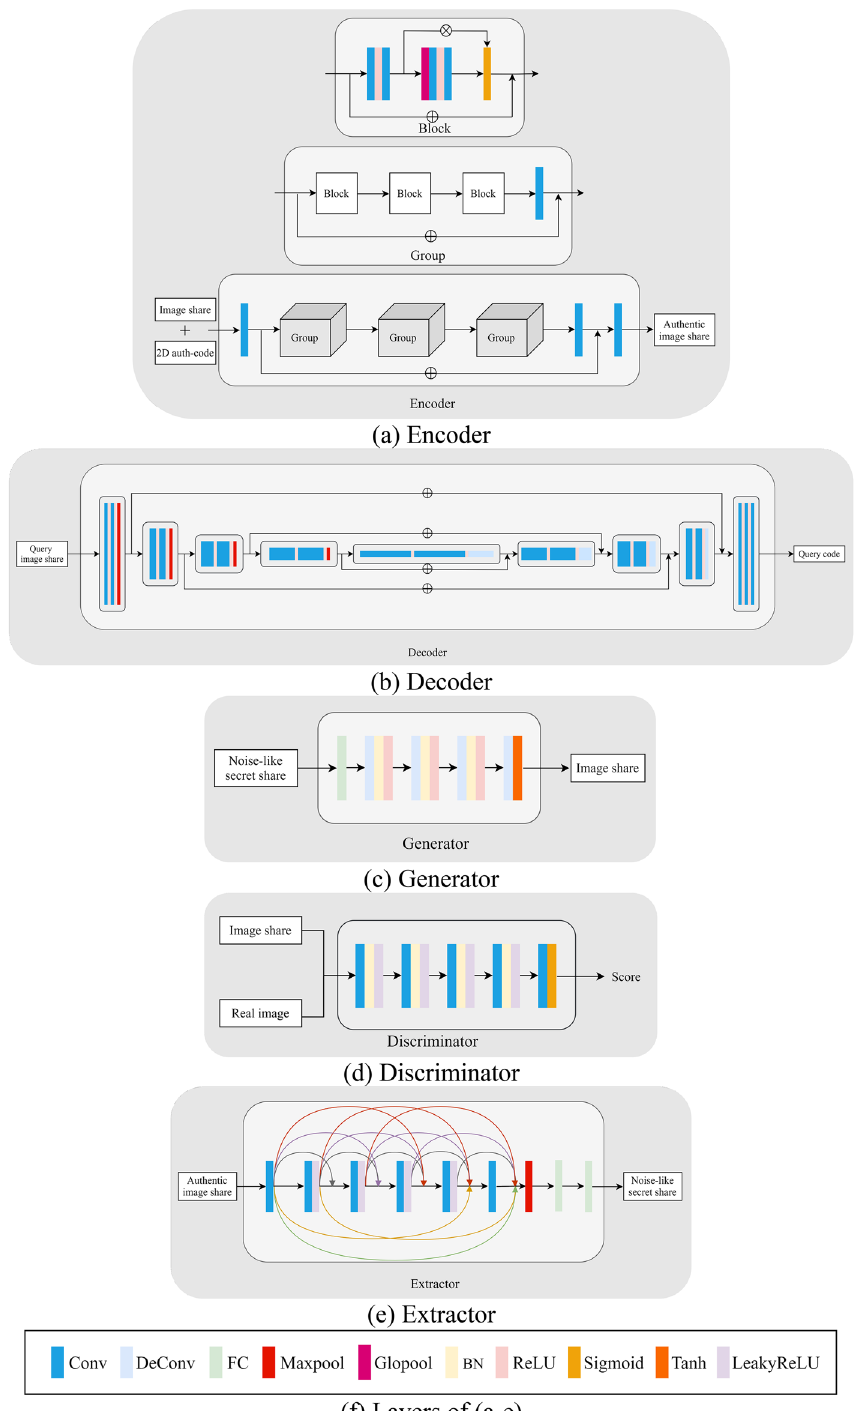
Fig. 2 Architectural details of models for steganographic secret